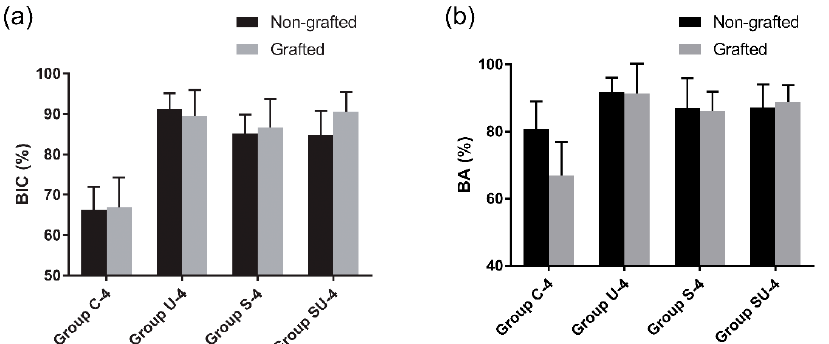
Figure 9. Comparisons between the nongrafted sides and the grafted sides in the 4-week group, as evaluated by histomorphometry. ( a ) BIC; ( b ) BA. Data are expressed as mean ± standard deviations. Error bars show the standard deviations. Note that there is no significant difference between the nongrafted sides and the grafted sides in terms of BIC and BA ( p > 0.05), regardless of the treatment methods used. BIC, bone-to-implant contact; BA, bone area.